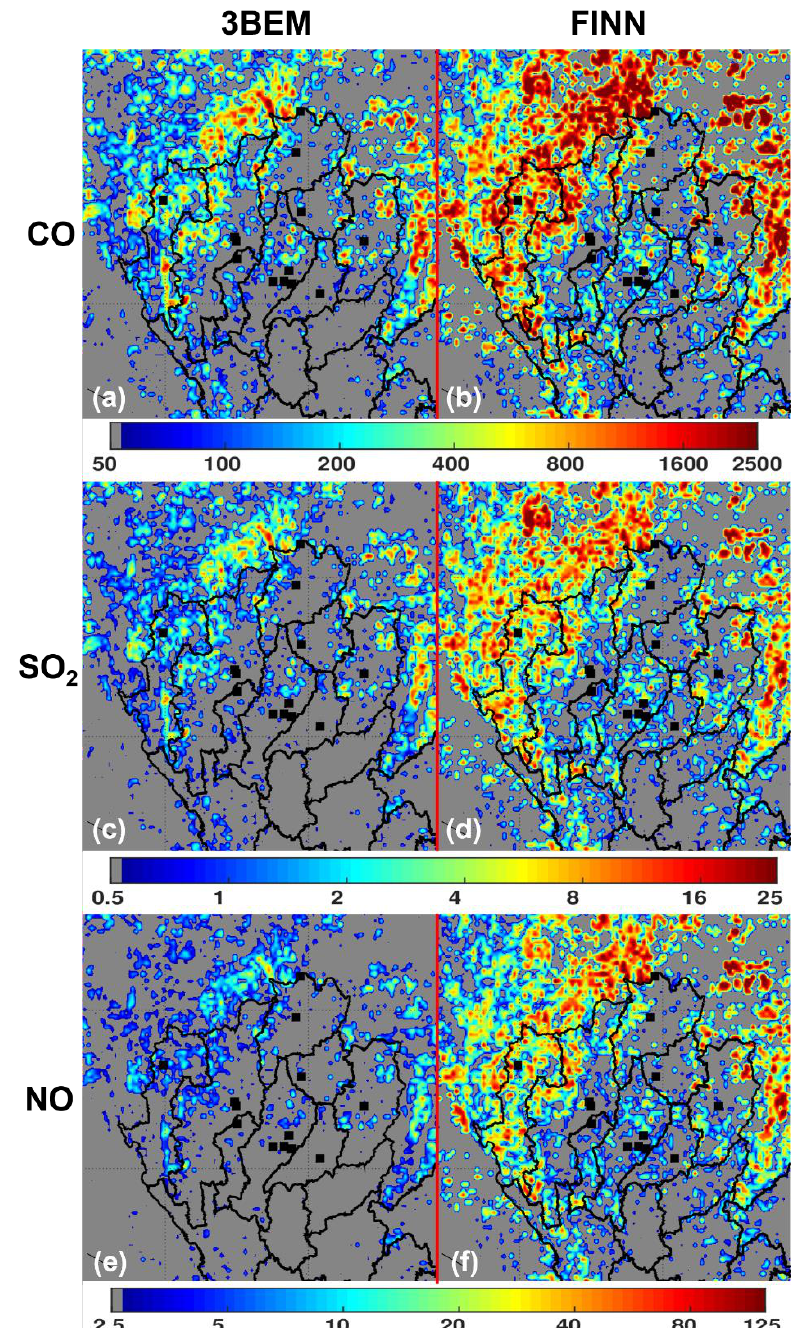
Figure 17. Comparisons of daily total 3BEM ( a , c , e ) and FINN ( b , d , f ) emissions (kg m − 2 day − 1 ) over the study area averaged over 31 days in March 2015. Top to bottom rows: CO, SO 2 , and NO emissions, respectively. The black squares in each sub-figure show the locations of ground stations employed in this study. Table 10. Daily total 3BEM and FINN emissions (kg m −2 day −1 ) of CO, SO 2 , and NO averaged over the study area and over 31 days in March of 2014 and 2015.